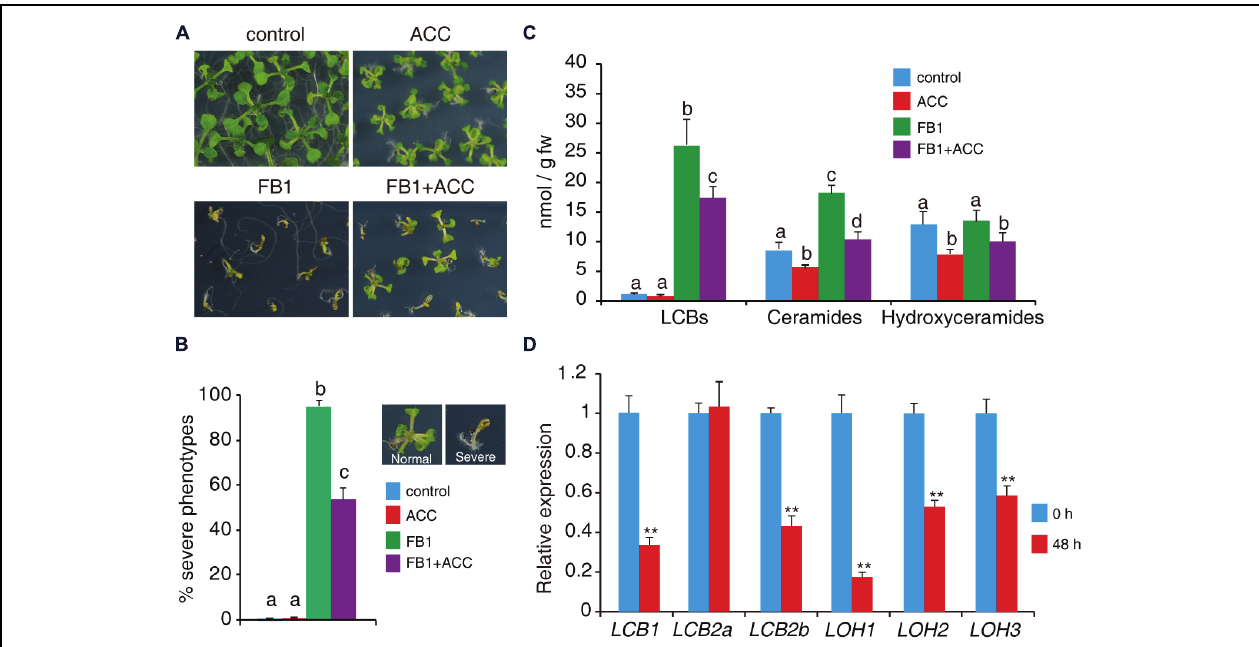
FIGURE 7 | ACC reduces FB1-induced cell death. (A) Wild-type seeds were germinated on 1/2x MS supplemented with various combinations of 0.5 µ M FB1 and 50 µ M ACC. Photos were taken after 2 weeks of treatment. (B) Quantitative analysis of the phenotype of seedlings in (A) . At least 100 seeds of each sample were used in each experiment. Data presented are means ± SD ( n = 3) and sets marked with different letters indicate significances assessed by Student–Newman–Keul test ( P < 0.05). (C) Sphingolipid analysis of wild-type seedlings treated with various combinations of ACC and FB1. One-week-old seedlings were used and harvested after 6 days of treatment. Total sphingolipids were extracted and analyzed (see Supplementary Figure S2 for the detailed analysis). (D) Expression of genes involved in de novo sphingolipid synthesis in wild-type seedlings after 48 h ACC treatment. Data represent means ± SD from three technical repeats and sets marked with double asterisks indicate significance assessed by Student’s t -test ( P < 0.01). This experiment was repeated three times with similar